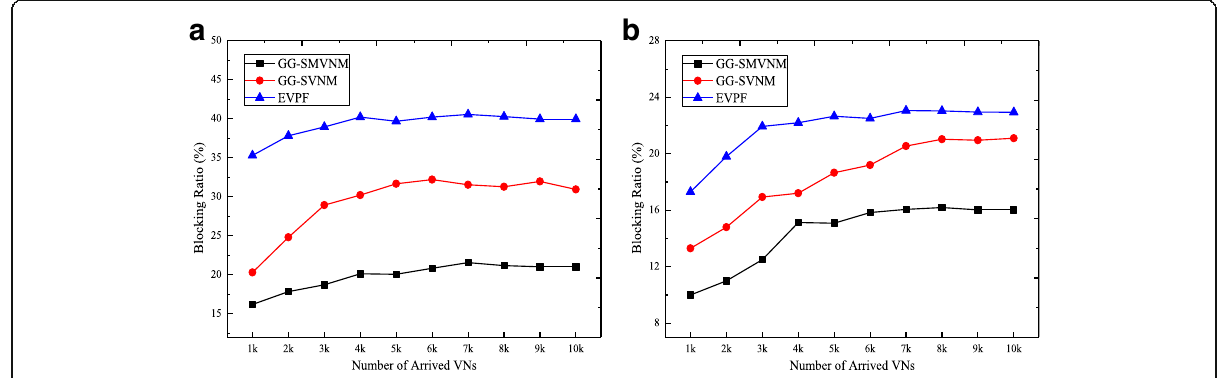
Fig. 11 Simulation results on blocking ratio. a Simulation results on Net-1. b Simulation results on